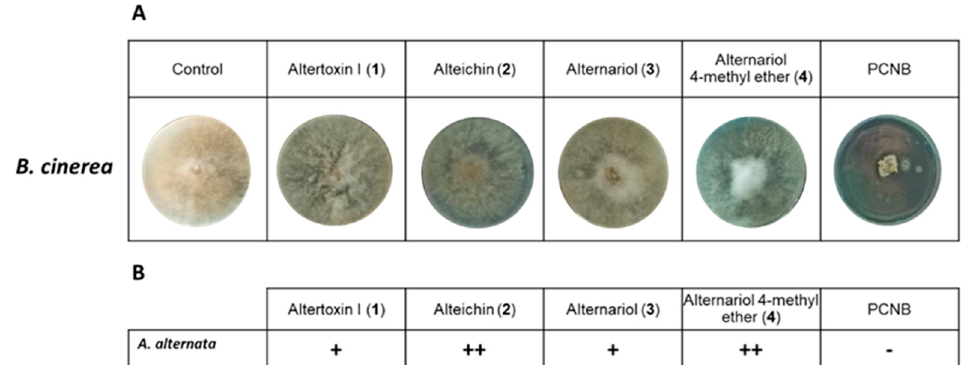
Figure 7. In vitro antagonistic effect of compounds isolated from A. alternata . A: representative photographs of antifungal activity against B. cinerea of compounds 1 – 4 isolated from A. alternata compared with the positive control pentachloronitrobenzene (PCNB) at a final concentration of 5 × 10 − 3 M. B: evaluation of inhibition growth: +: low inhibition; ++: medium inhibition; -: no growth.